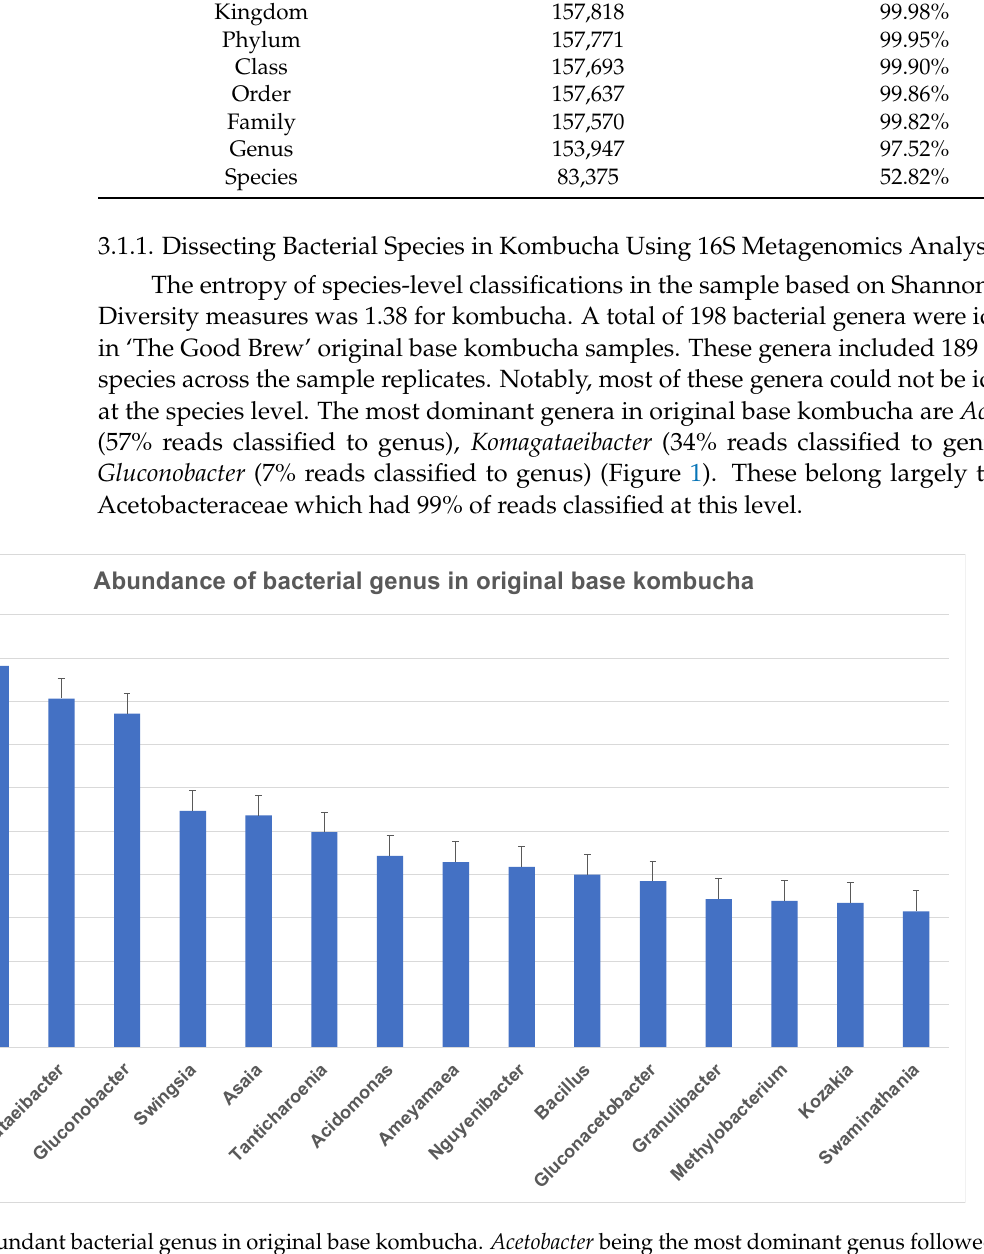
Table 1. Read mapping and classification statistics.